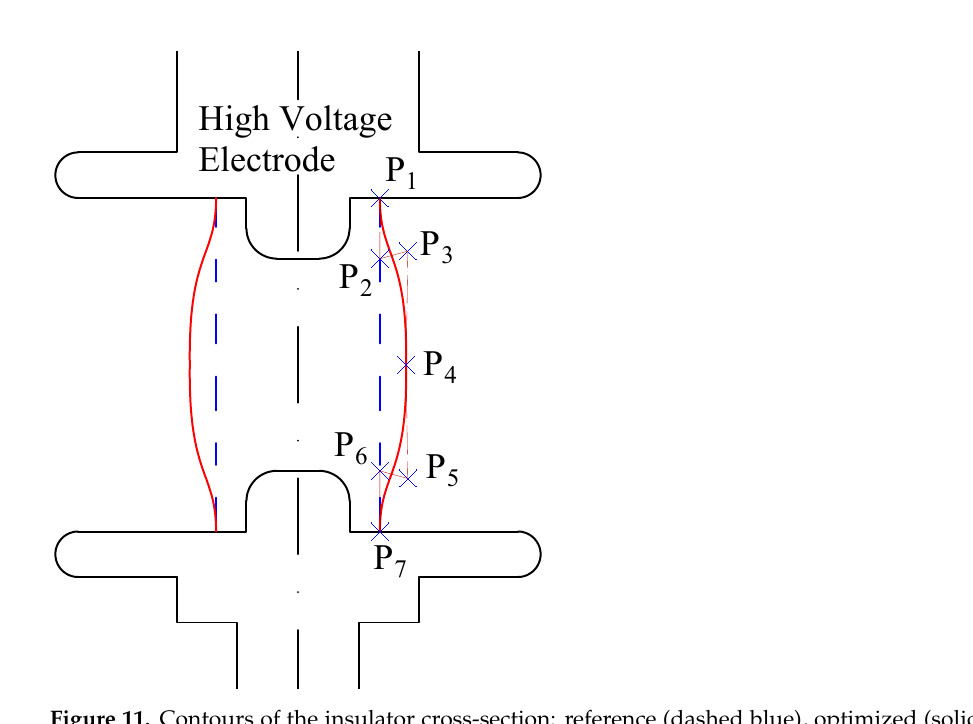
Figure 11. Contours of the insulator cross-section: reference (dashed blue), optimized (solid red). × symbols represent the control points of Bézier curve for which only P3 and P4 are used as design variables.